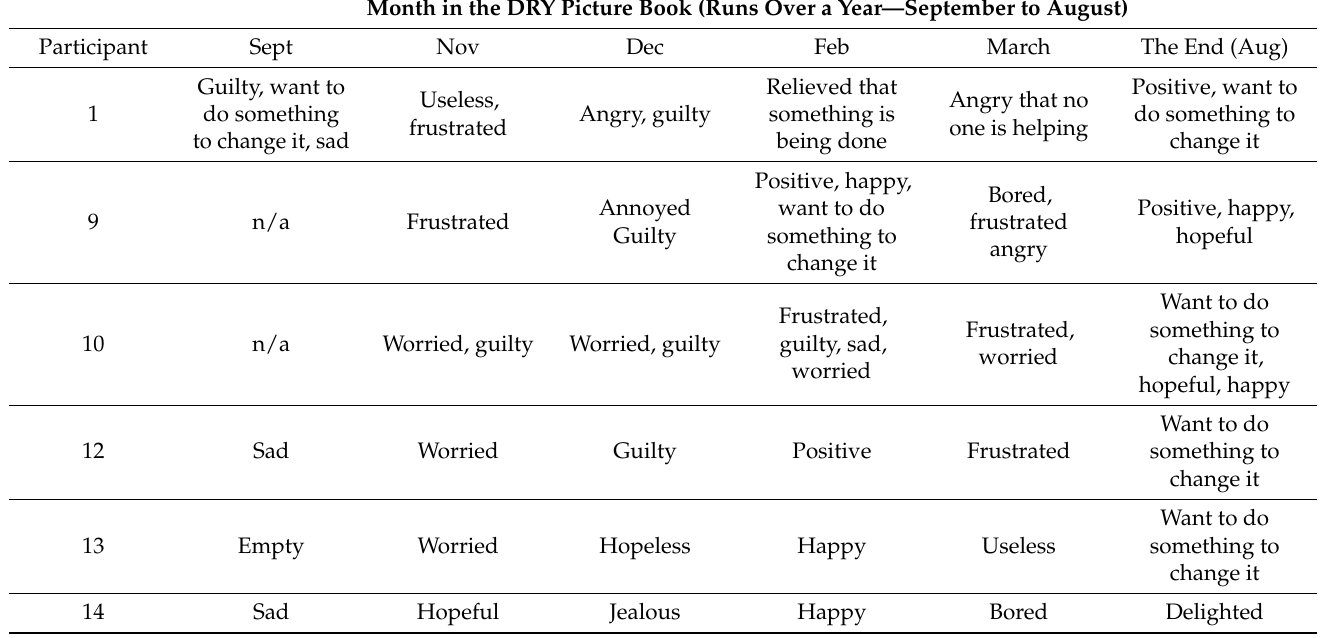
Table 1. Examples of the emotional responses to the narrative in the DRY picture book. Month in the DRY Picture Book (Runs Over a Year—September to